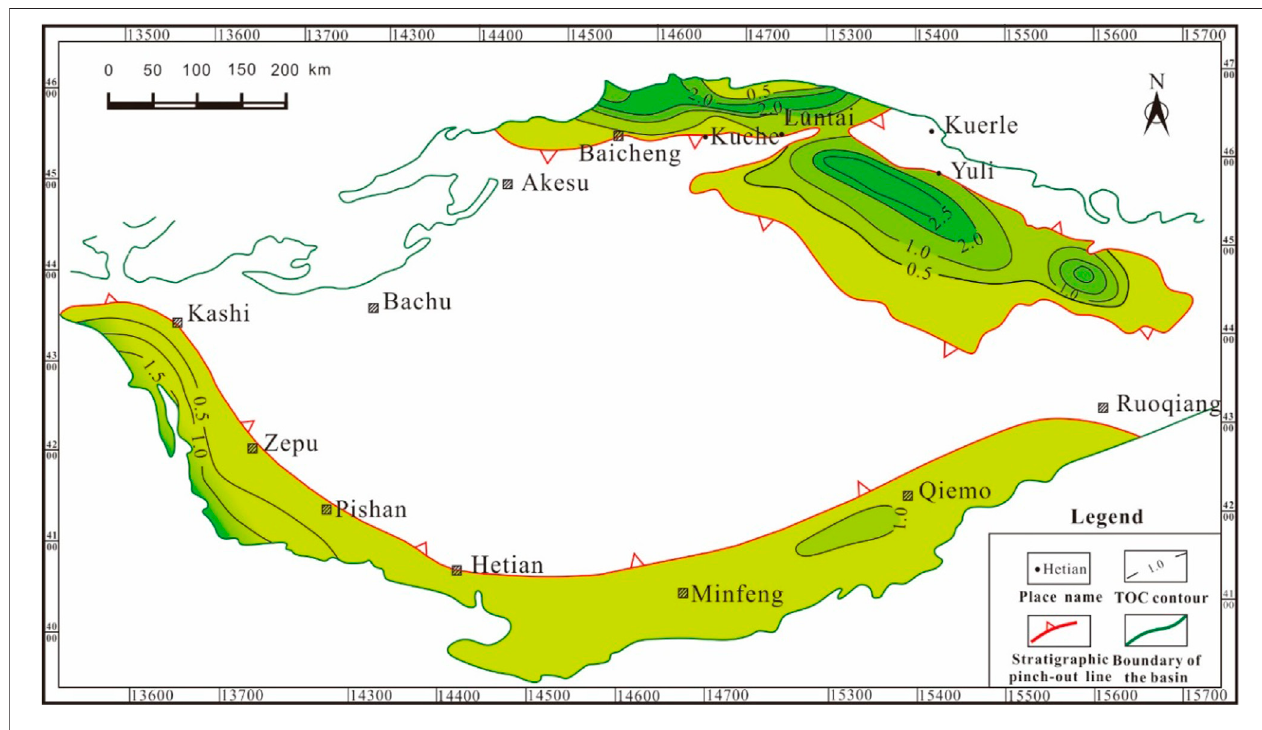
FIGURE 4 | Contour map of TOC of Lower Jurassic in the Tarim Basin.